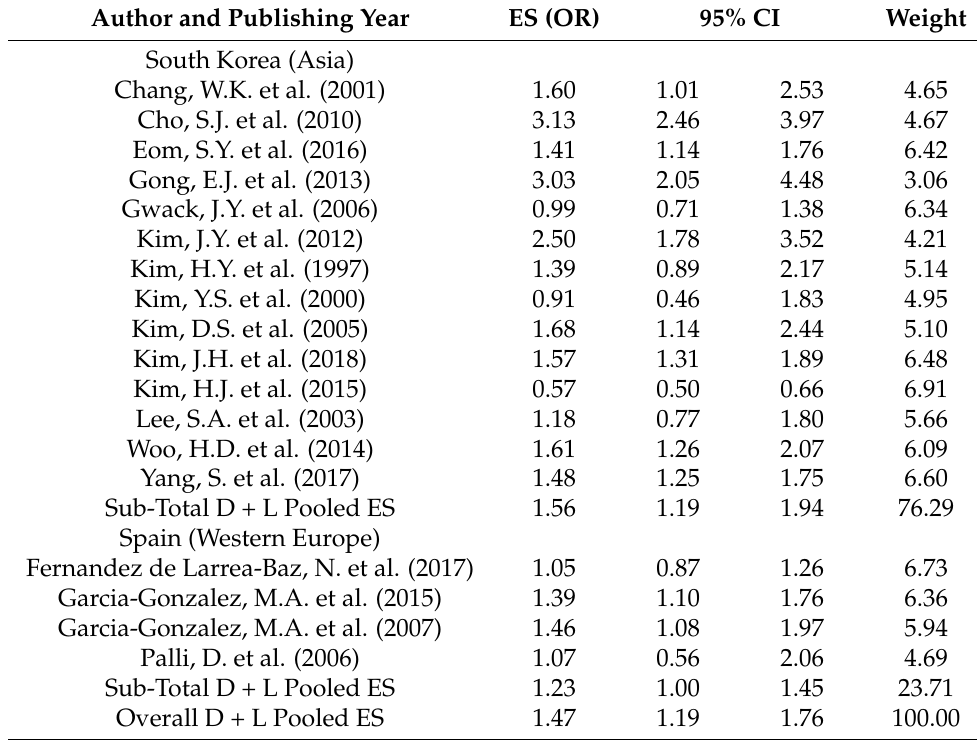
Table 3. Unadjusted and pooled point-estimates from studies in South Korea and Spain with regards to H. pylori infection and gastric carcinoma